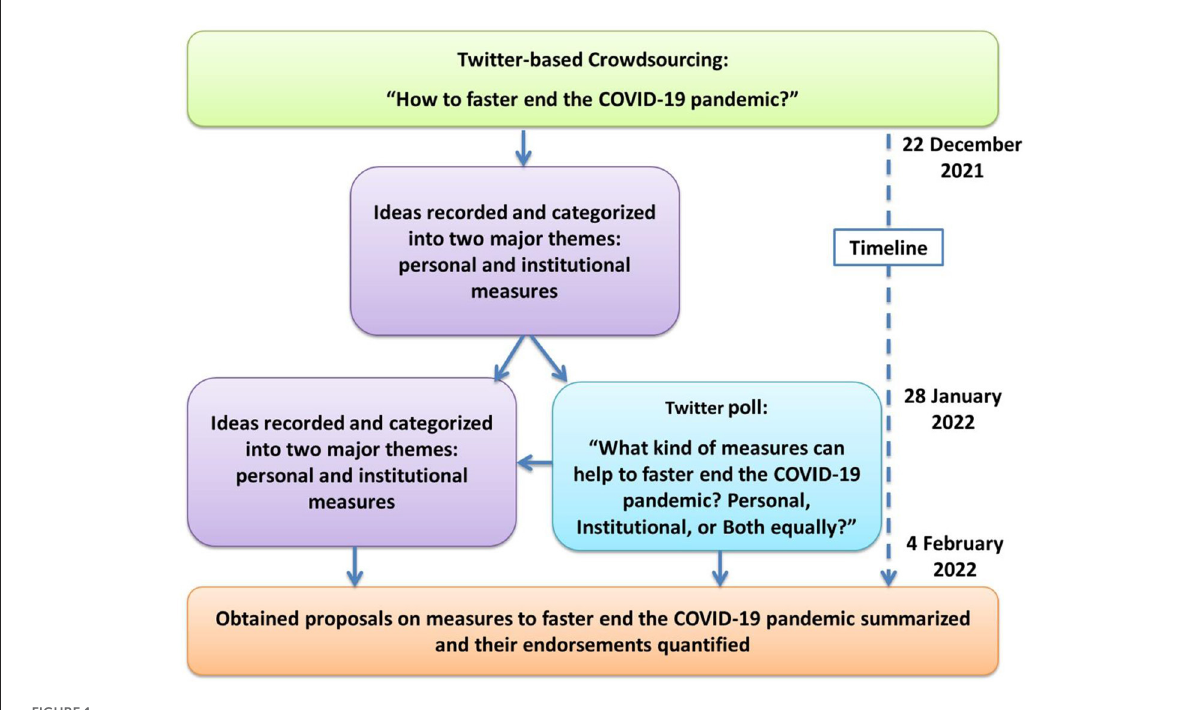
FIGURE1 The applied study protocol, including the consequently conducted steps and the respective